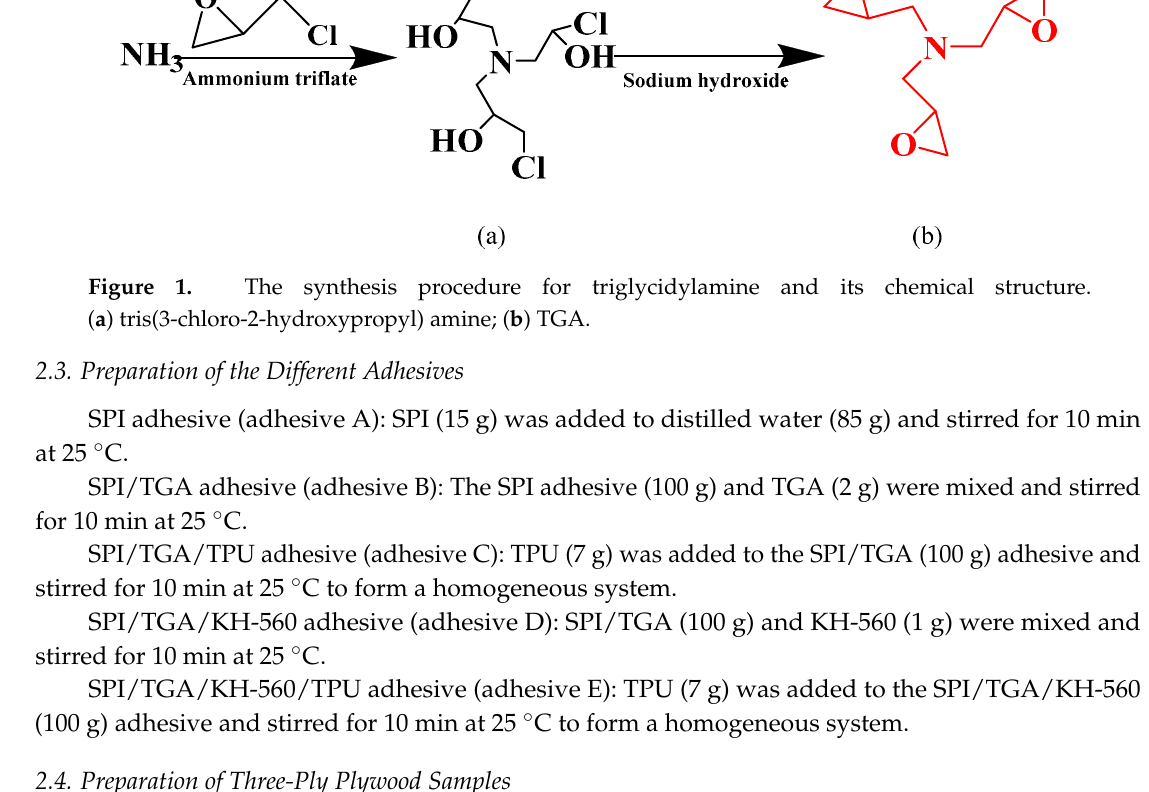
Table 1. Hot-pressing